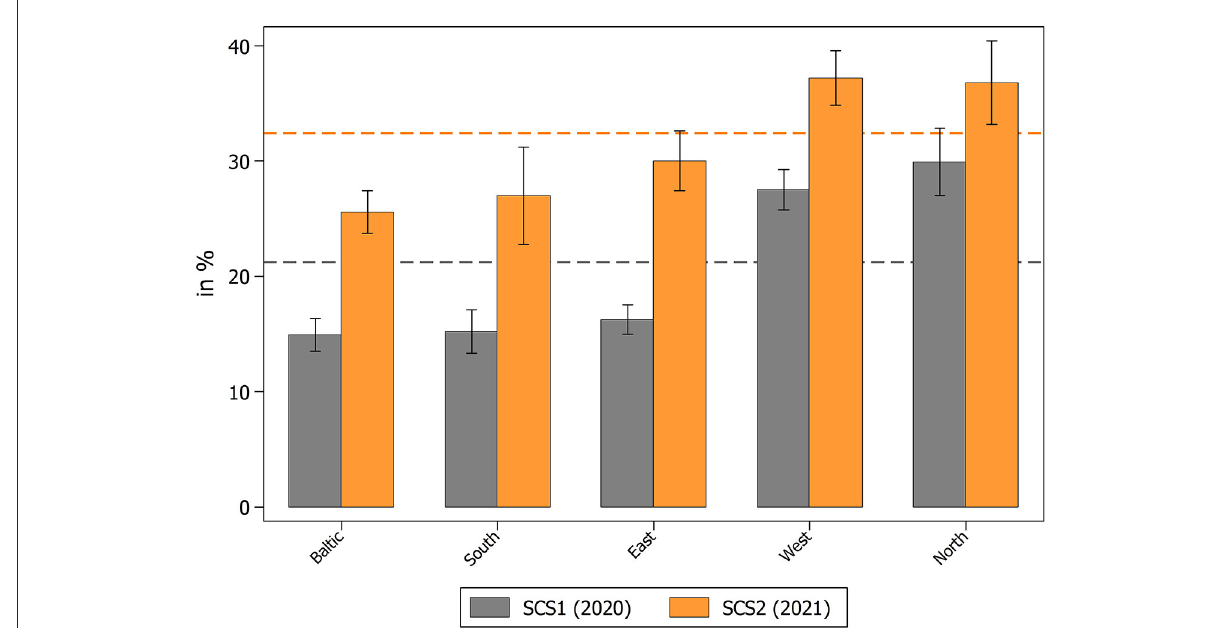
FIGURE1 Percent of respondents providing help to others outside their own household since the outbreak of the pandemic. Data: SHARE Wave 8 COVID-19 Survey 1 and SHARE Wave 9 COVID-19 Survey 2, Release 8.0.0 ( n = 47,495, respectively; weighted) with 95% confidence intervals.